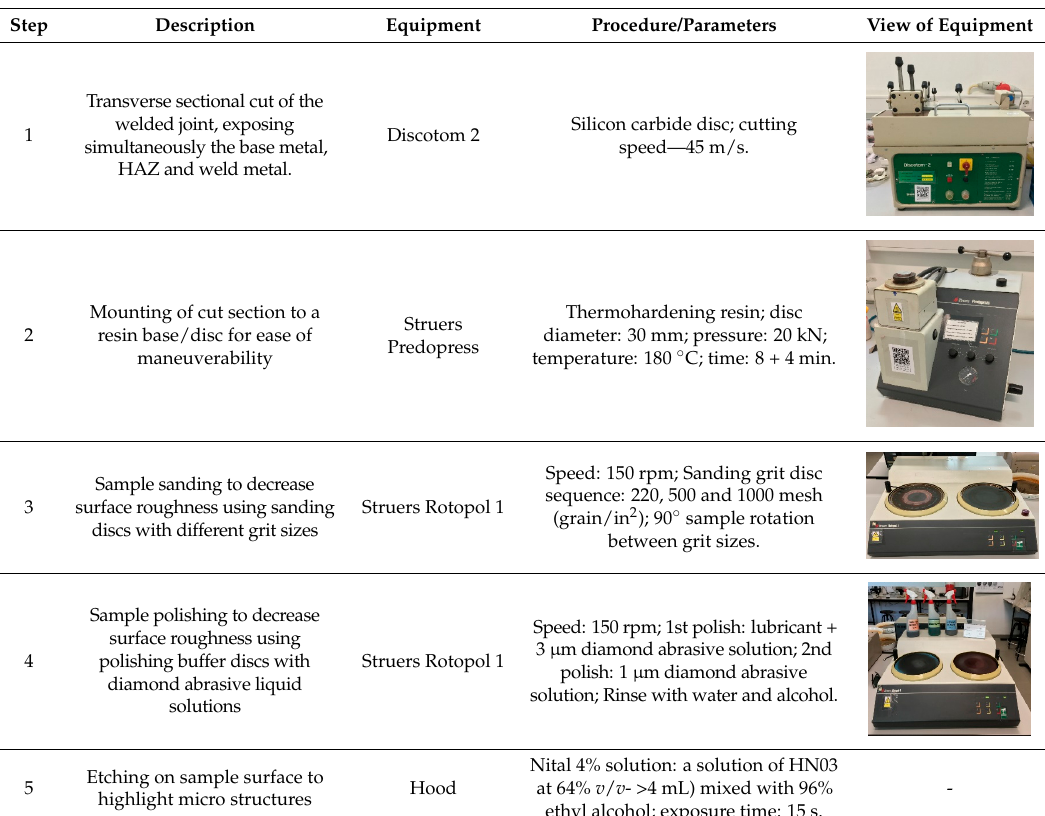
Table 3. Sample preparation steps for viewing on microscope.